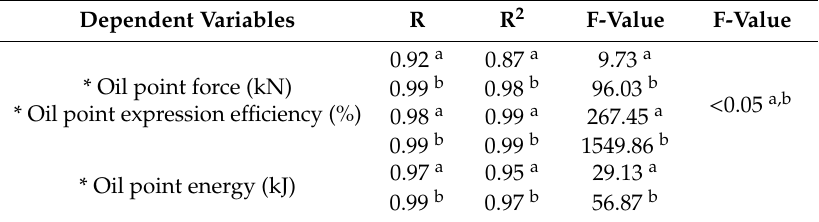
Table 8. ANOVA and correlation results of oil point force, oil expression e ffi ciency and